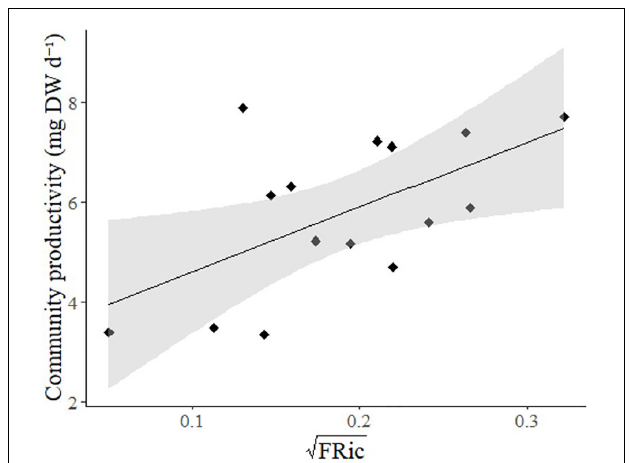
FIGURE 2 | Relationship between Functional Richness (FRic, square root transformed) and community productivity (mg DW d − 1 ). Solid line: line of best fit, shaded area: 95% confidence